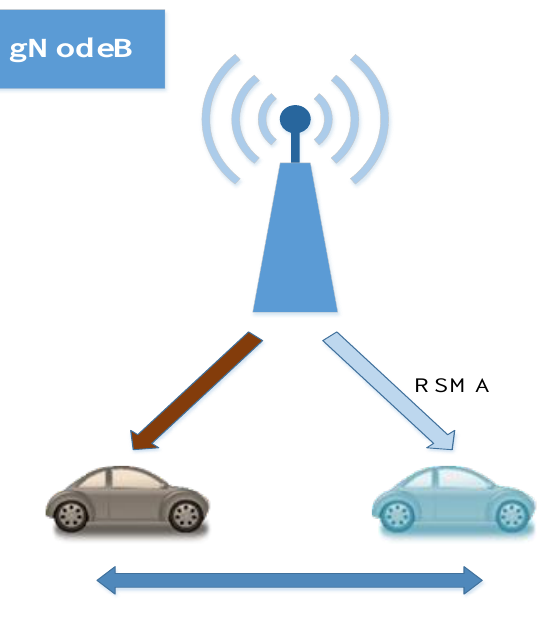
Figure 1. RSMA 5G V2X